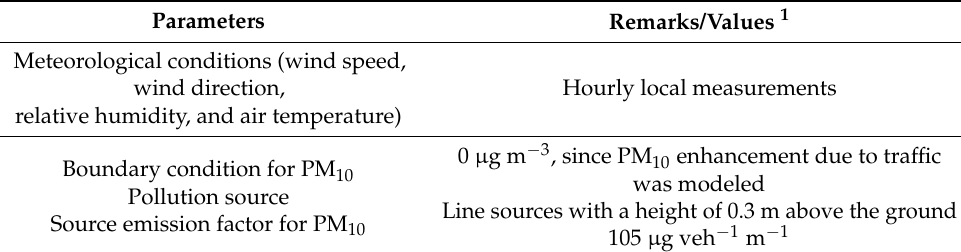
Table 2. The CFD model settings.